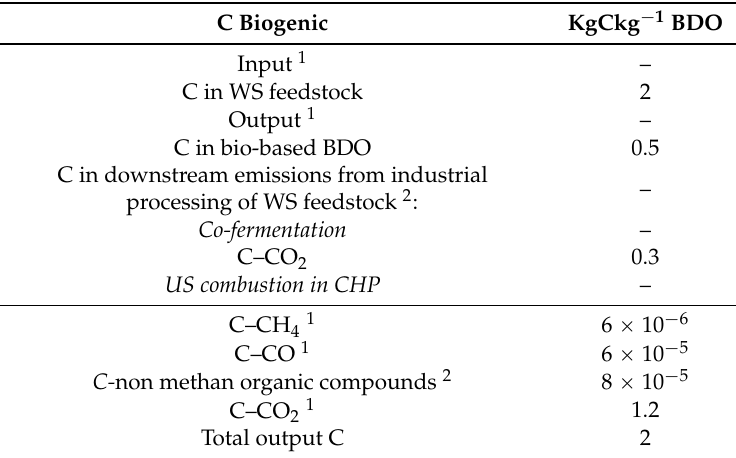
Table 4. C biogenic balance related to 1 kg of bio-based BDO